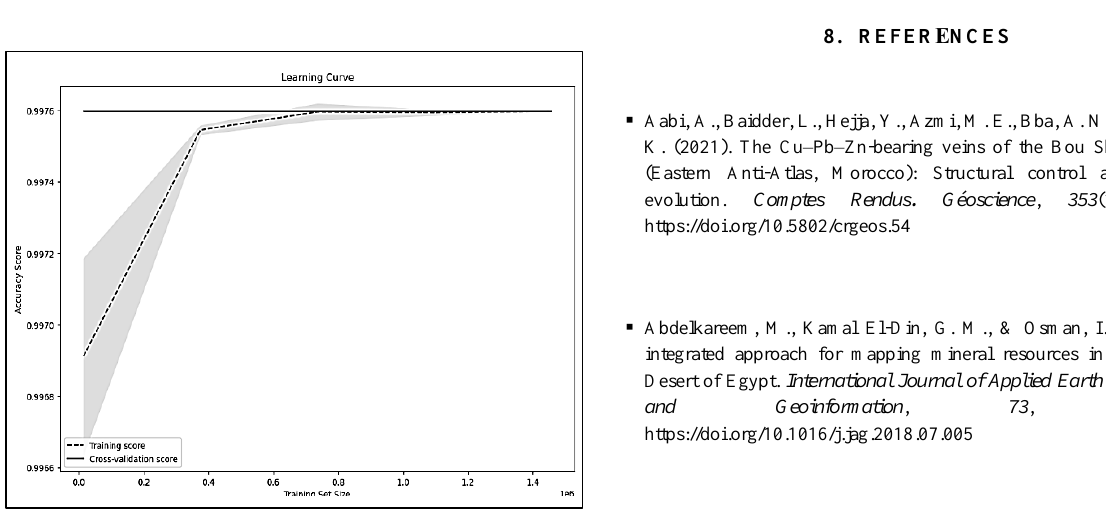
Figure 20: Artificial Neural Network Learning